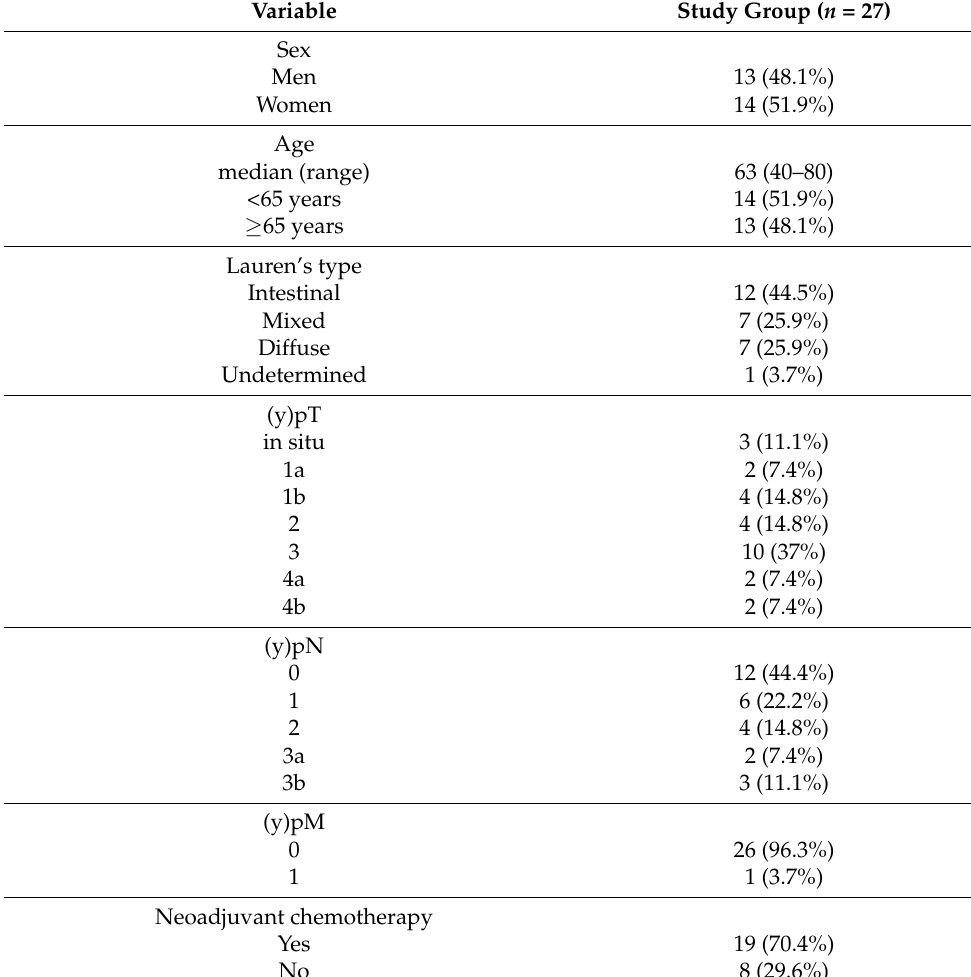
Table 1. Patients’